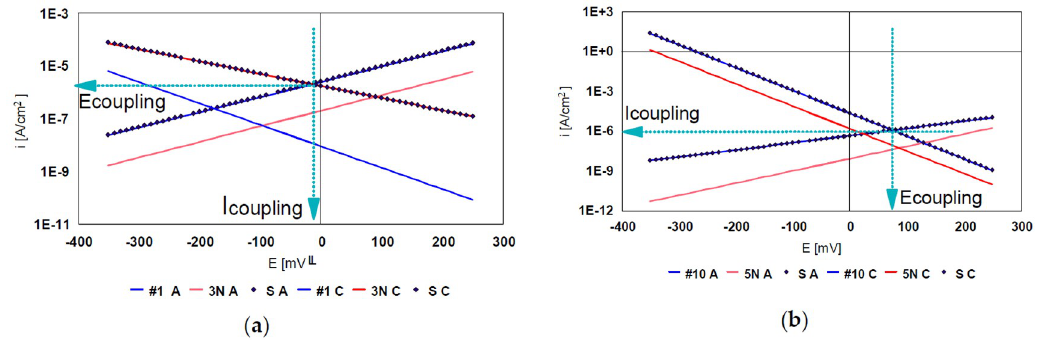
Figure 13. Determination of I coupling and E coupling for the coupling gold 18K/steels. ( a ) Coupling #1/3N; ( b ) Coupling #10/5N.